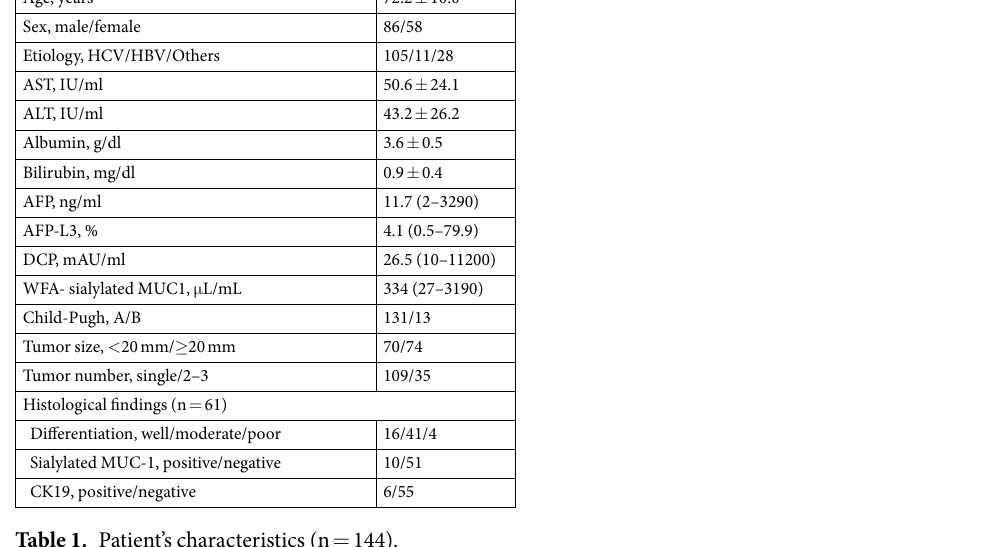
Table 1. Patient’s characteristics (n =